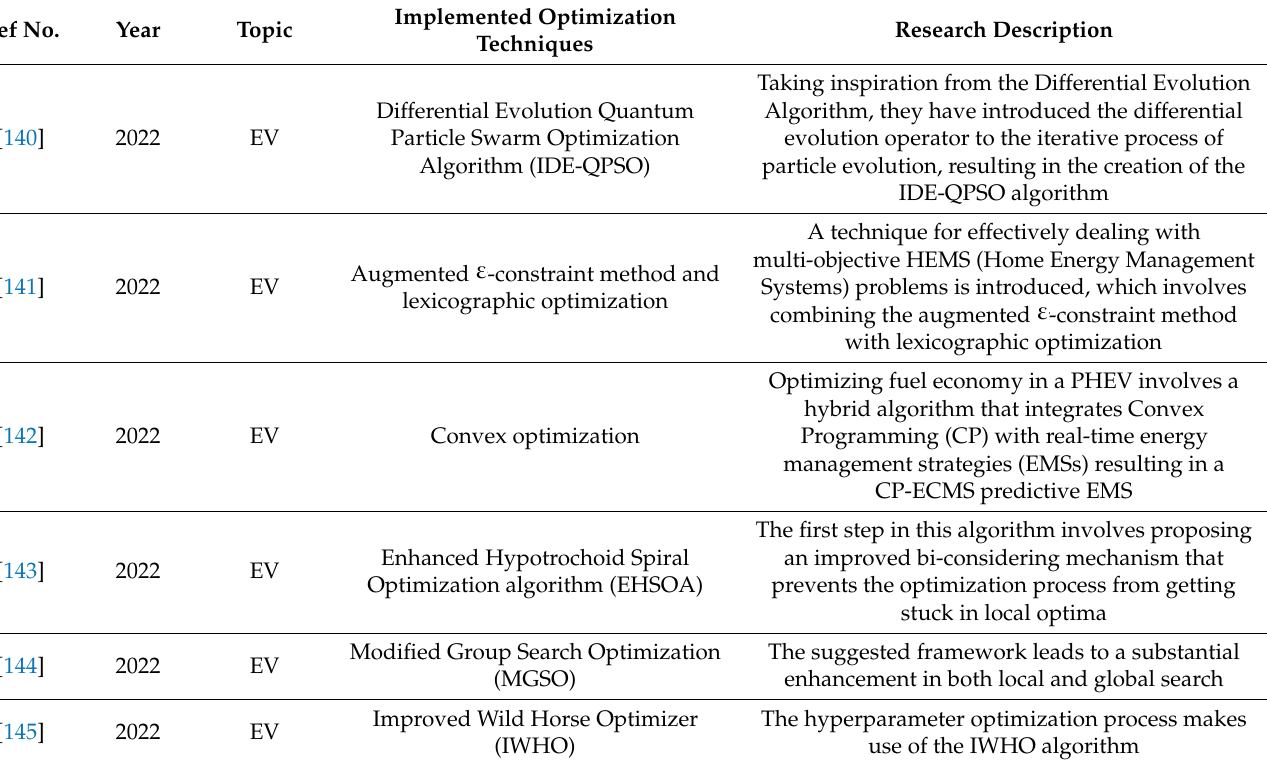
Table 7. Summarization and contribution of optimization techniques applied in the field of EV and